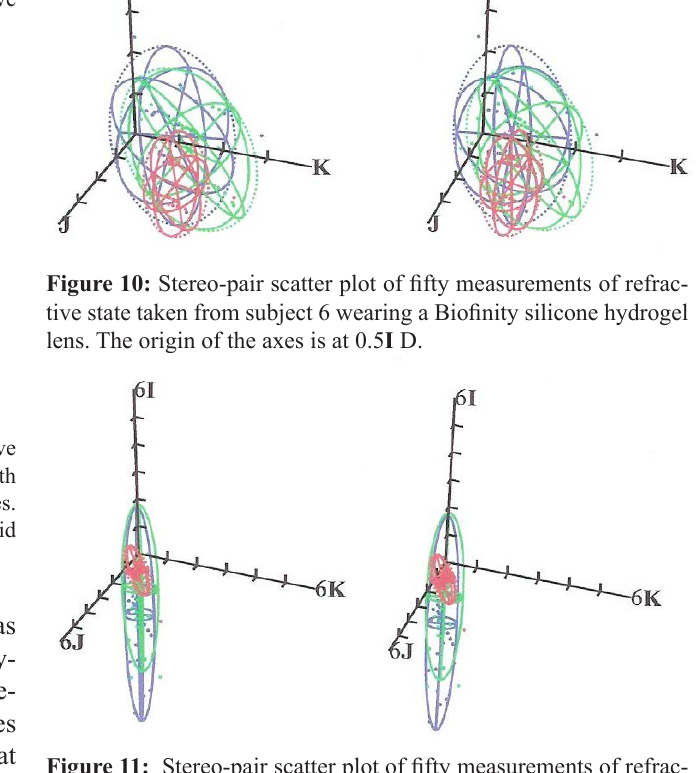
Figure 11: Stereo-pair scatter plot of fifty measurements of refrac- tive state taken from subject 7 wearing a Biofinity silicone hydrogel lens. The origin of the axes is at 1 I D. Axis length is six dioptres, necessary to place all thee ellipsoids on one set of